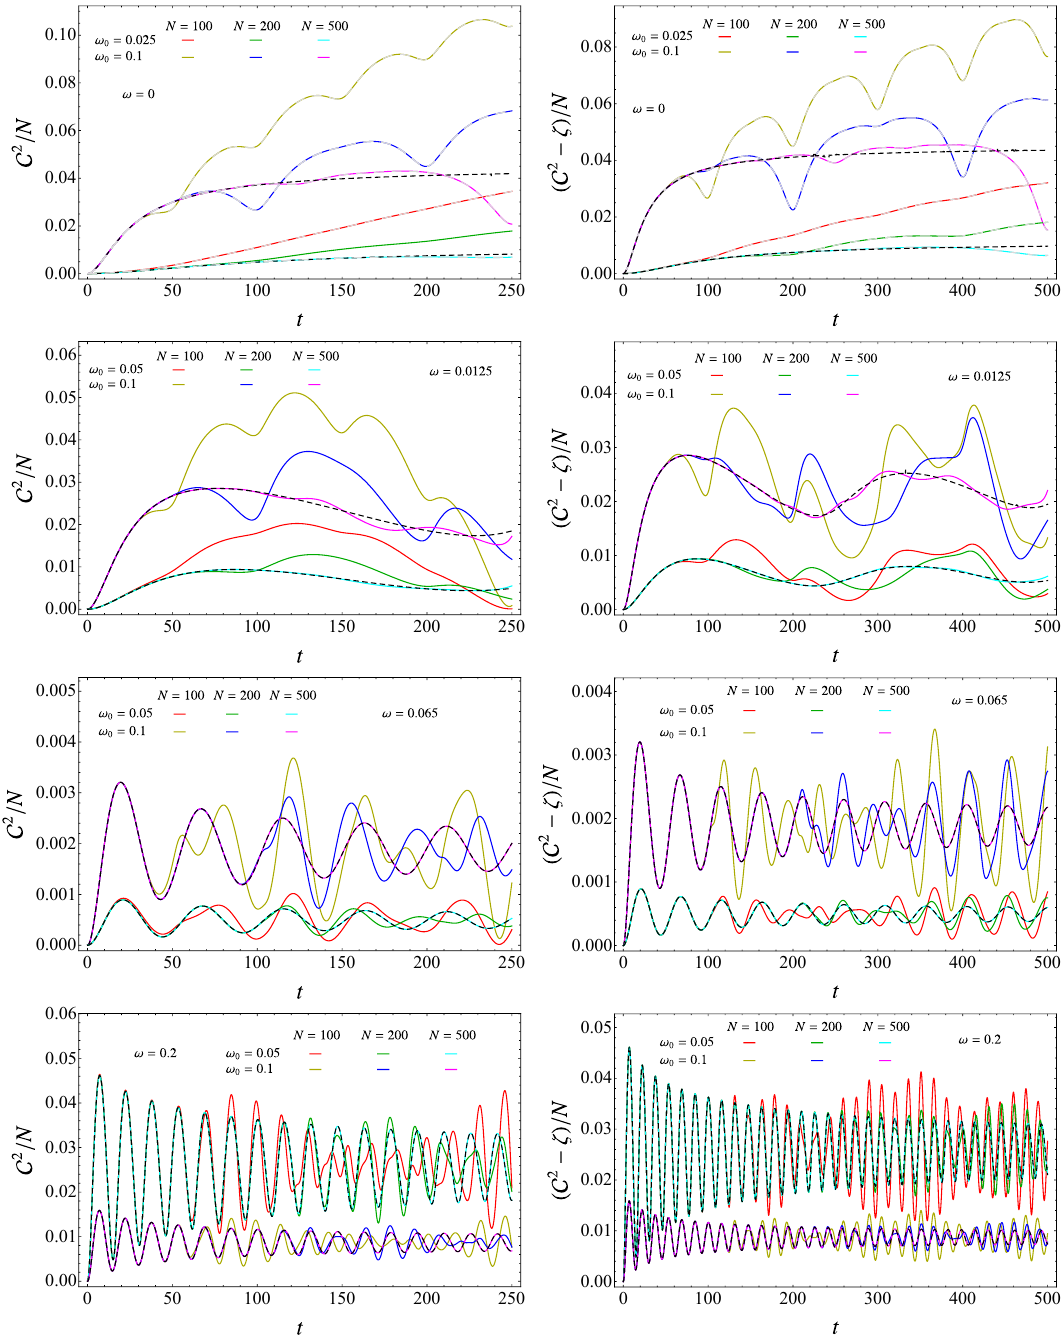
Figure 4 . Temporal evolutions of the complexity for harmonic chains with either PBC (left panels) or DBC (right panels). The solid lines show C 2 /N for PBC and ( C 2 − ζ ) /N for DBC, with C given by (3.7) and ζ by (C.19). The dashed black lines represent C 2